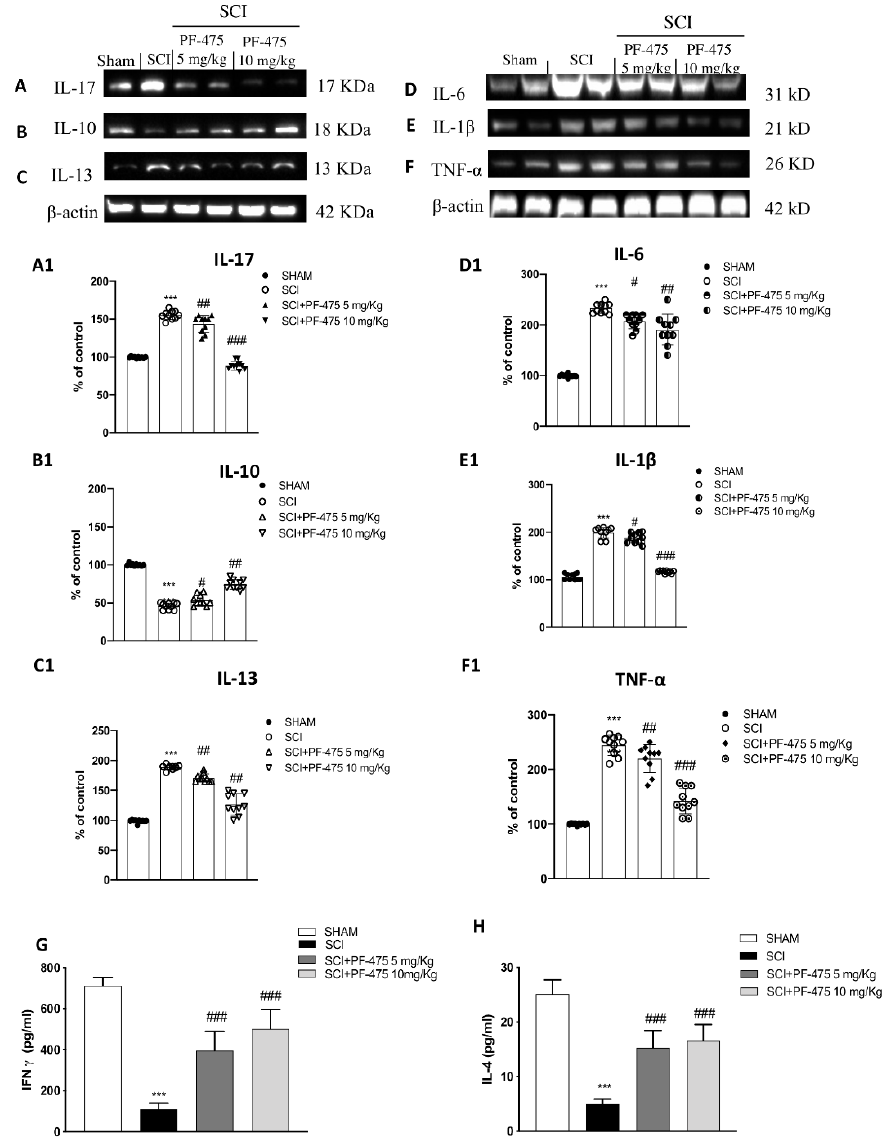
Figure 5. Effects of PF-475 on cytokine expression after SCI. Cytosolic fractions of spinal cord tissues were used to evaluate inflammatory cytokines expression such as IL-17, IL-13, IL-6, IL- 1β , and TNF- α, representative blots are shown. Representative blots of inflammatory cytokines such as IL-17, IL- 13, IL-6, IL- 1β , and TNF- α are shown (( A , C – F ), see densitometric analysis ( A1 , C1 – F1 ). Expression level of the anti-inflammatory cytokine IL-10 ( B ); see densitometric analysis ( B1 ). Data represent the means of at least three independent one-way ANOVA experiments followed by post hoc Bonferroni *** p < 0.001 vs. Sham; # p < 0.05; ## p < 0.01 and ### p < 0.001 vs. SCI. ELISA method was performed for detection of TNF- α and IL -4 in total protein extract of spinal cord tissues (( G , H ) respectively). Each data is expressed as SD from ten mice for each group. One-way ANOVA followed by Bonferroni post-test. *** p < 0.001 vs Sham; ### p < 0.001 vs. SCI. The samples used derive from the same experiment and those gels/blots were processed in parallel. 4. Discussion Although accumulated evidence shows that modulation of the inflammatory pathway and immune response is crucial in modifying the mechanisms underlying neurodegeneration, neuronal cell death, and related dysfunctions after SCI, the exact mechanism is not fully understood [27]. Certainly, scientific evidence affirms that metabolic imbalances within the spinal cord after injury are responsible for the initiation